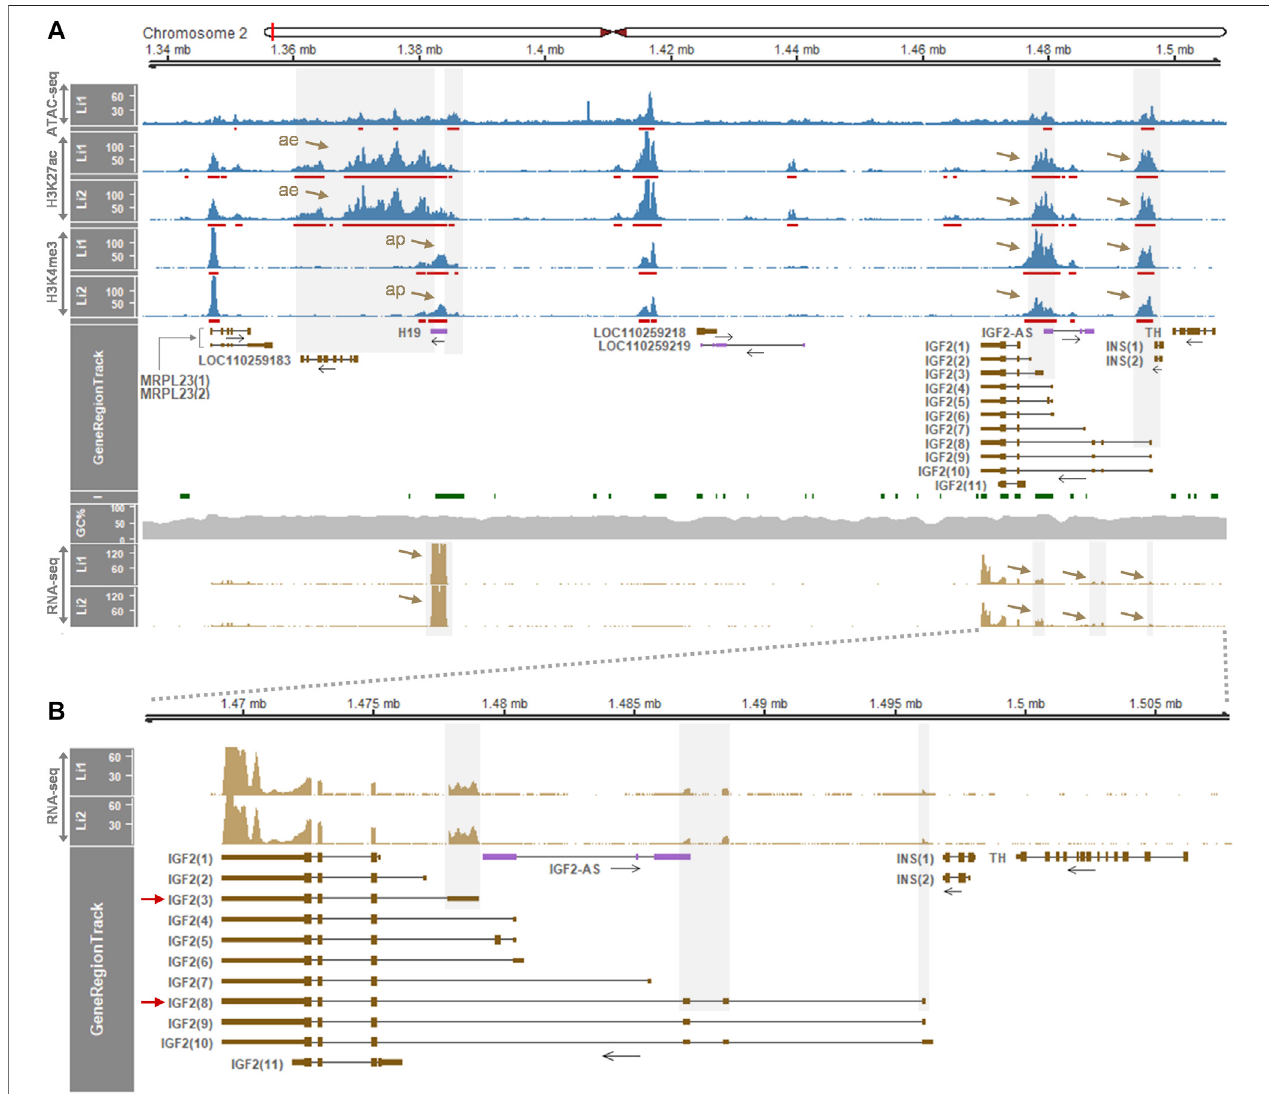
FIGURE3| Enrichmentofgeneregulatorysignalsandexpressionofgeneswithinthe H19/IGF2 locusoftheliverof2-week-oldpigs. (A) ATAC-seq,H3K27ac,and H3K4me3 signals intheliver (Li)oftwoLarge White pigs arerepresentedwith 1xnormalized read coverages. Red bars indicate MACS2-calledpeaks. Bothgrey shades and brown arrows denote gene regulatory signals and gene expression. ae, active enhancer; ap, active promoter. (B) Expression pattens of the IGF2 transcripts is zoomed in. Both IGF2(3) and IGF2(8) are expressed in the same liver tissues of the 2-week-old pigs. Data were retrieved from GSE143288.